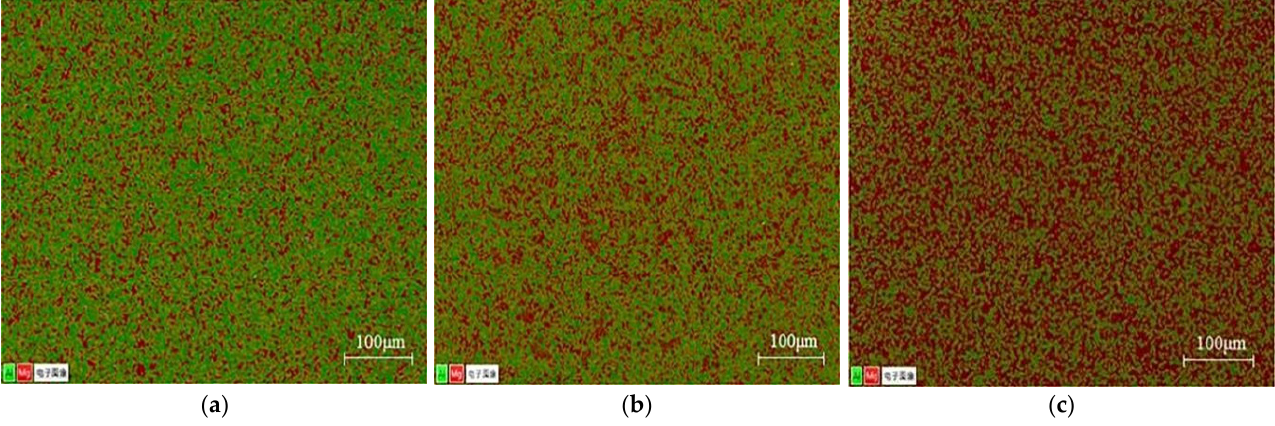
Figure 6. EDS surface scanning analysis of different diffusion layers: ( a ) Mg 2 Al 3 layer, ( b ) Mg 17 Al 12 layer, and ( c ) Mg 17 Al 12 and Mg-based solid solution layer. Table 3. EDS results of the distinct regions presented in Figure 5.